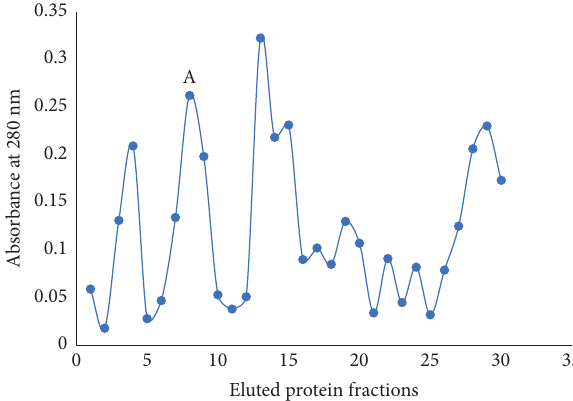
Figure 3: Elution profle of D. stramonium stem protein obtained from DEAE-cellulose column. Table 4: Purifcation of mosquito larvicidal protein from the stem of D. stramonium . S.